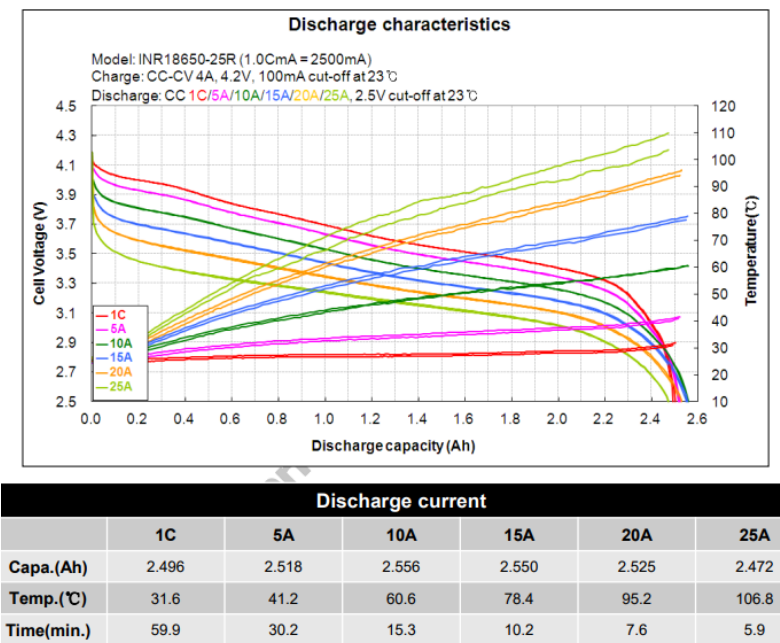
Figure 3. Discharging characteristics for various discharge currents [43]. Courtesy of SAMSUNG